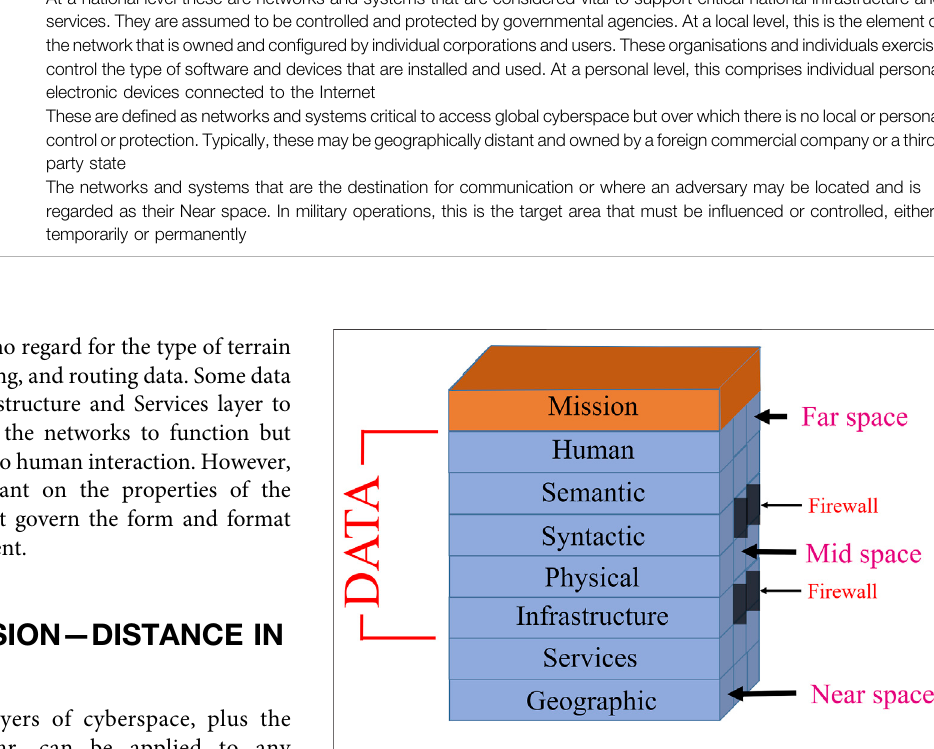
FIGURE 2 | The concept of distance in